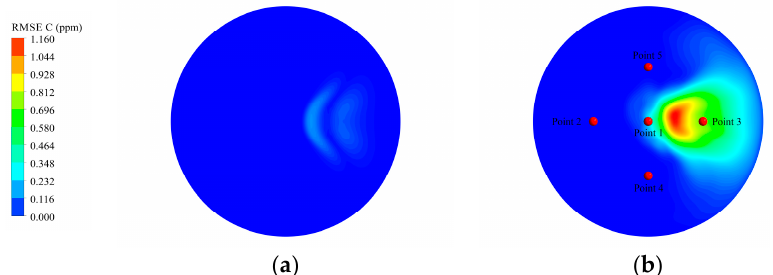
Figure 18. Comparisons of the RMSE pollutant concentration distribution at exit plane of cooling tower: ( a ) URANS and ( b ) LES.